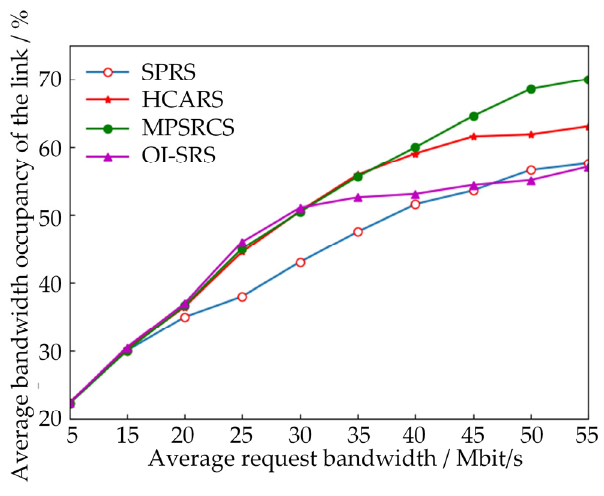
Figure 17. Comparison of average bandwidth occupancy.